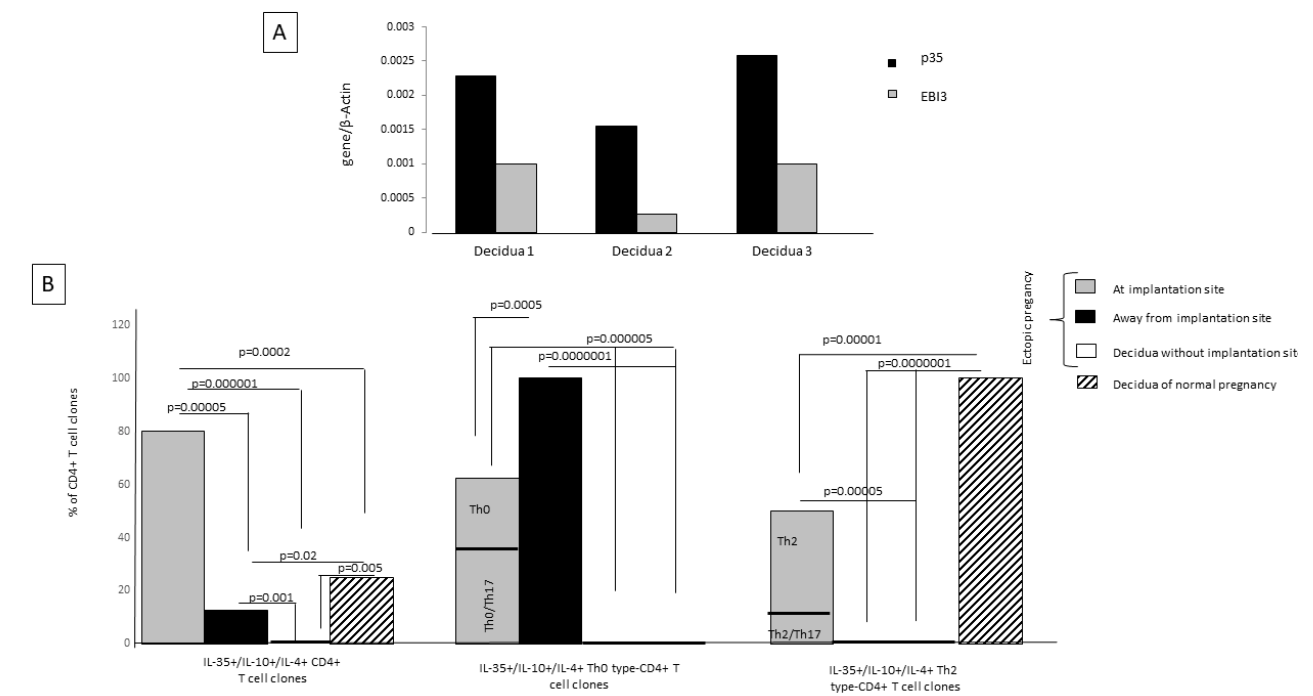
Figure 7. Th2 CD4+ T cells producing IL-35, IL-10, and IL-4 are exclusively present at the embryo implantation site and in the decidua of normal human pregnancy. ( A ) mRNA expression for p35 and EBI3 was evaluated in three decidua specimens of first-trimester normal pregnancy. ( B ) Seventy CD4+ T-cell clones were generated from each of these tissues: at the embryo implantation site and far from the implantation site of ectopic tubal pregnancies, from the decidua of the same women with ectopic pregnancy, where the implantation site was not present in the deciduae, but in the fallopian tube and from the deciduae of women with normal pregnancy with an embryo implantation site. The percentages of CD4+ T-cell clones, Th2-type T-cell clones, and Th0-type T-cell clones producing IL-35, IL-10, and IL-4 were determined in the different tissues.